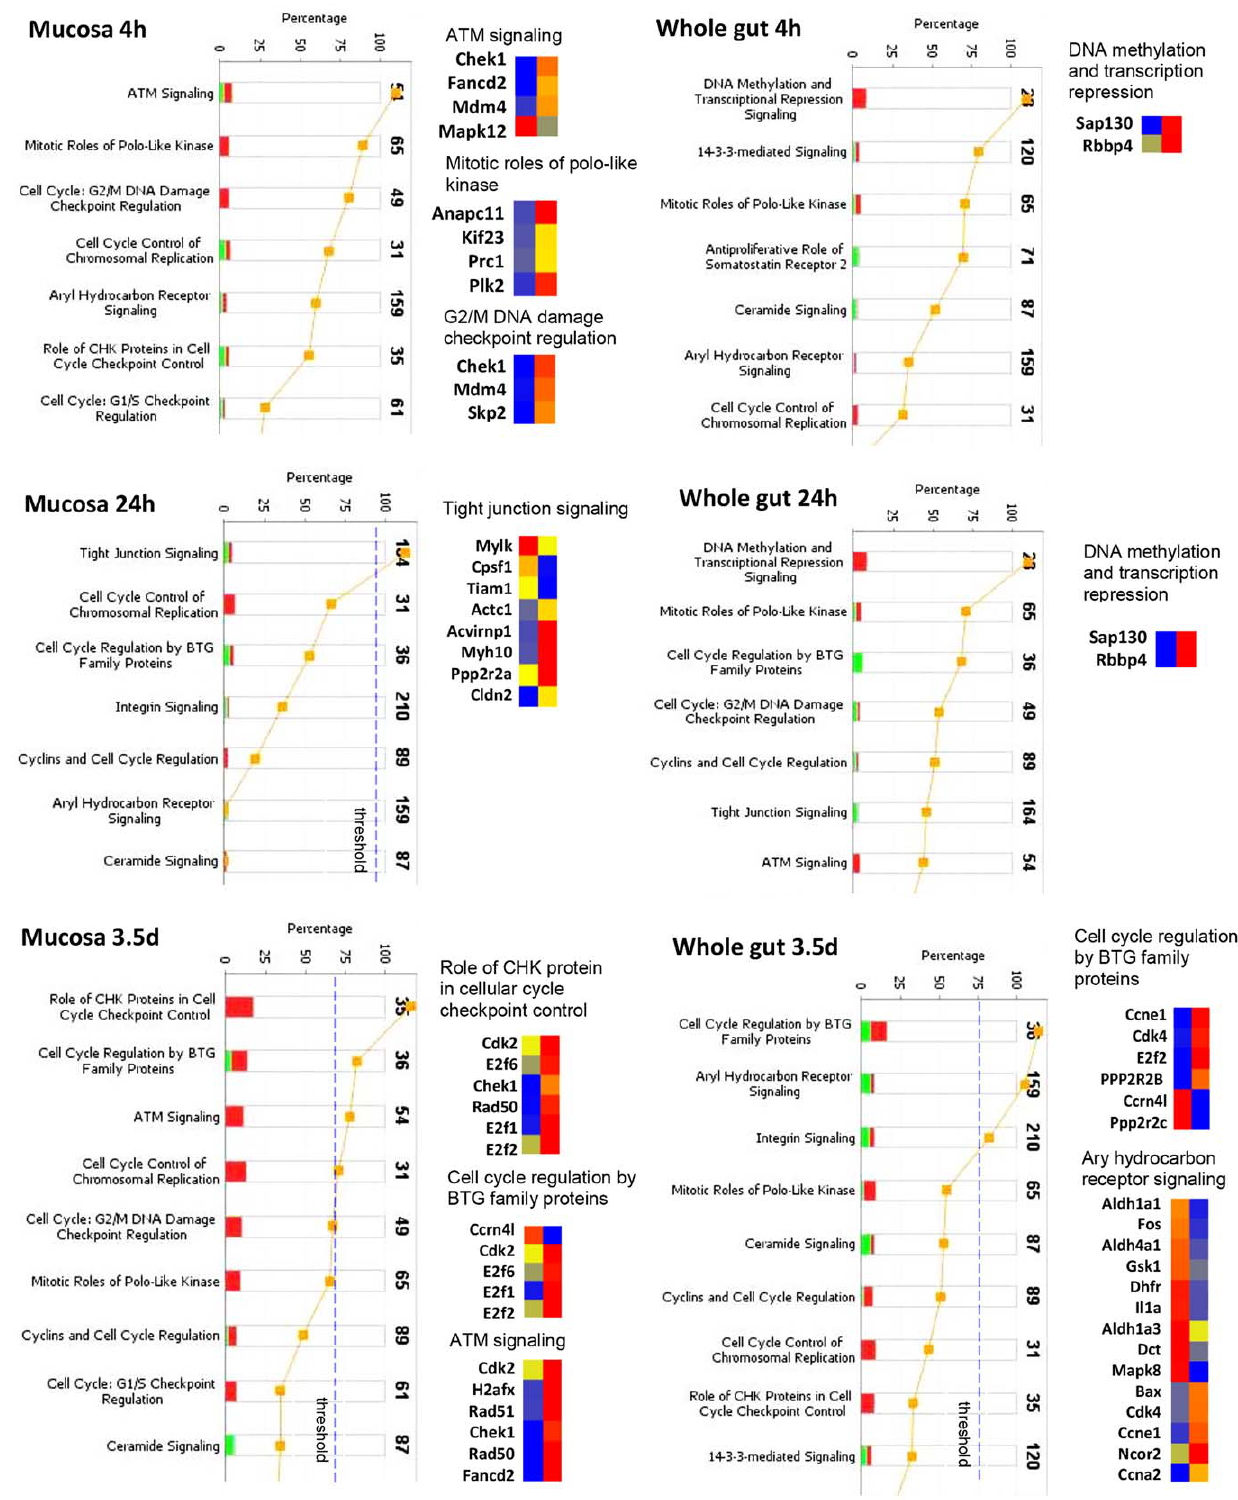
Figure 6. Activation of cell cycle control pathways in mucosa and whole gut. Stacked bar charts demonstrate IPA-generated activated cell cycle control pathways in mucosa and whole gut at 4 h, 24 h, and 3.5 d after irradiation. The height of the bars indicates the percentage of genes that changed in the particular pathway. Red bar: up-regulated. Green bar: down-regulated. Pathways with p-value (yellow dot) above the threshold (dashed line) are significantly activated. Heatmaps demonstrate the change of the genes in the selected signaling pathway before (left column) and after radiation (right column). Blue: decreased, red: increased.